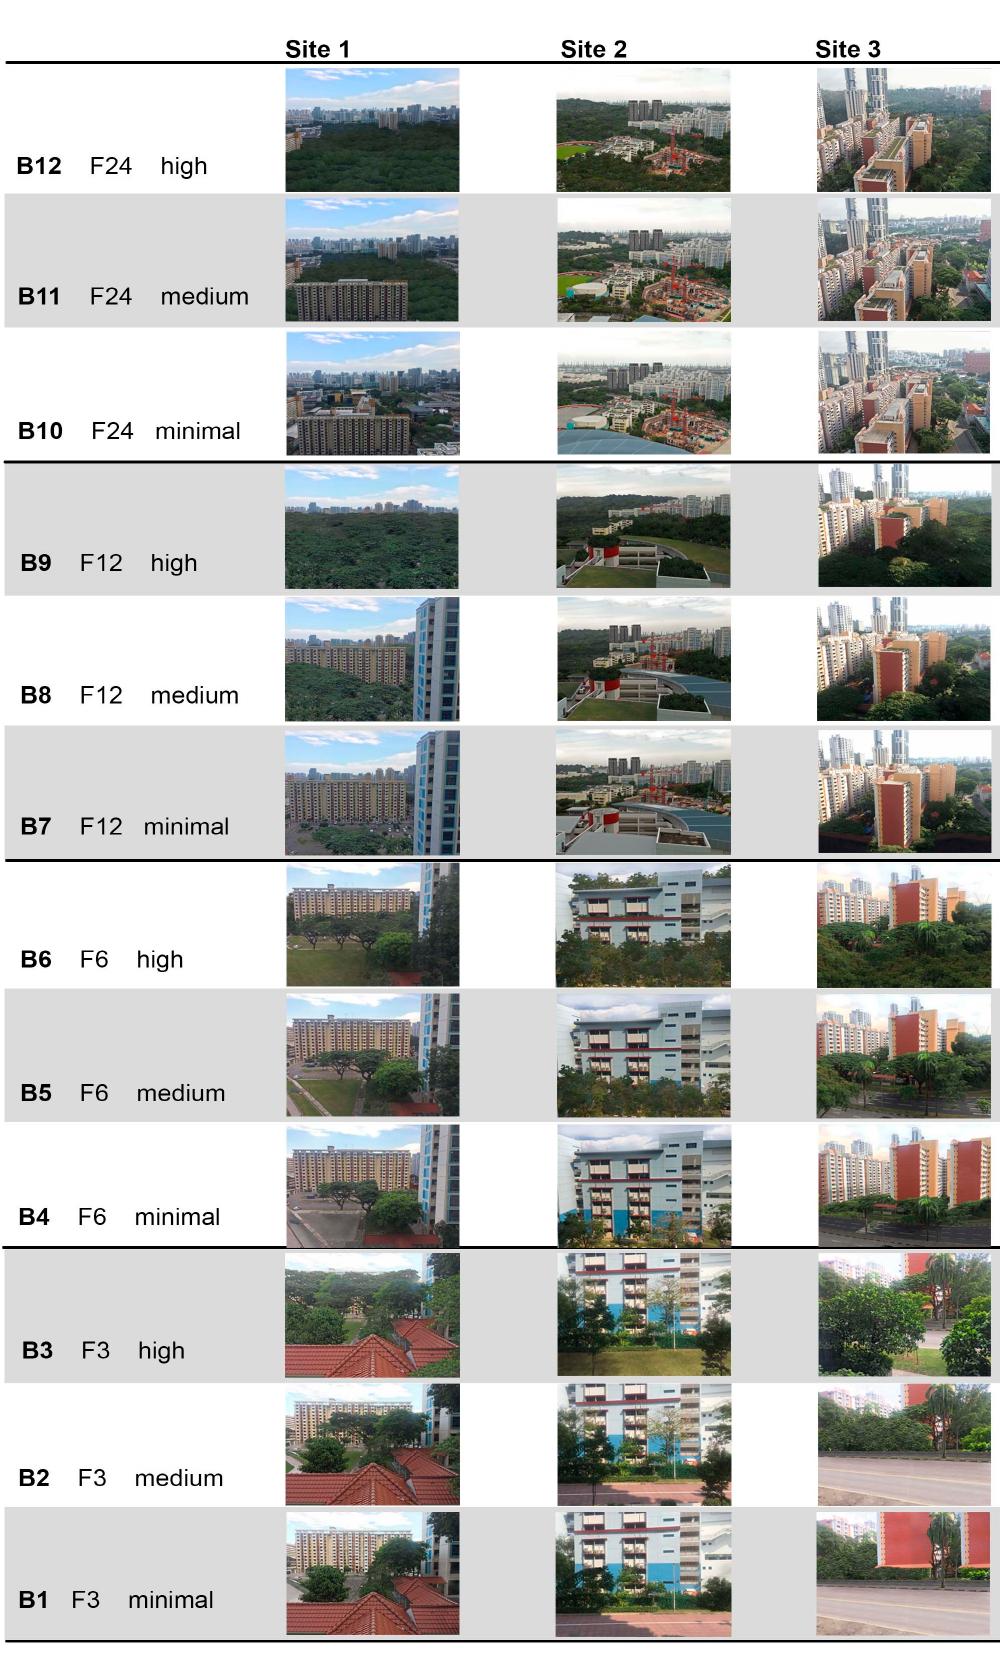
Figure 2. Photos of window views captured from three apartment buildings (Sites 1–3) and from four floor levels (F3—ground, 3rd floor, F6—6th floor, F12—12th floor, F24—24th floor) grouped into 12 blocks (B1–B12) and edited to fit into three green cover categories: minimal (<20%), medium (30–40%), and high (>50%).